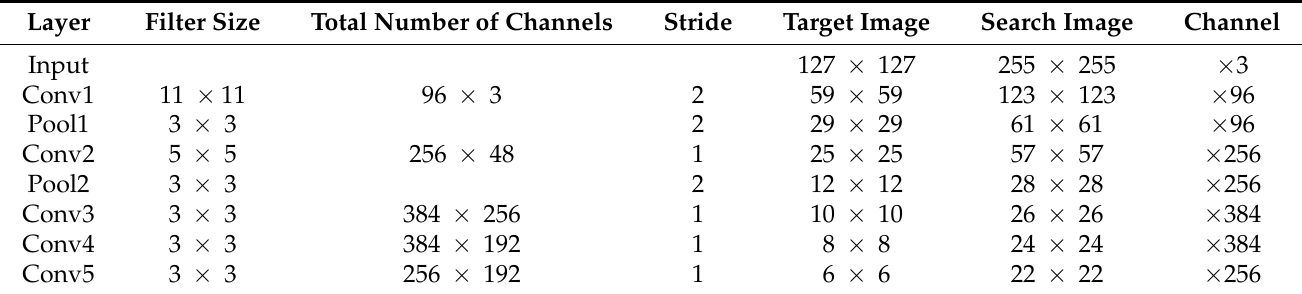
Table 3. Proposed network architecture for convolutional feature